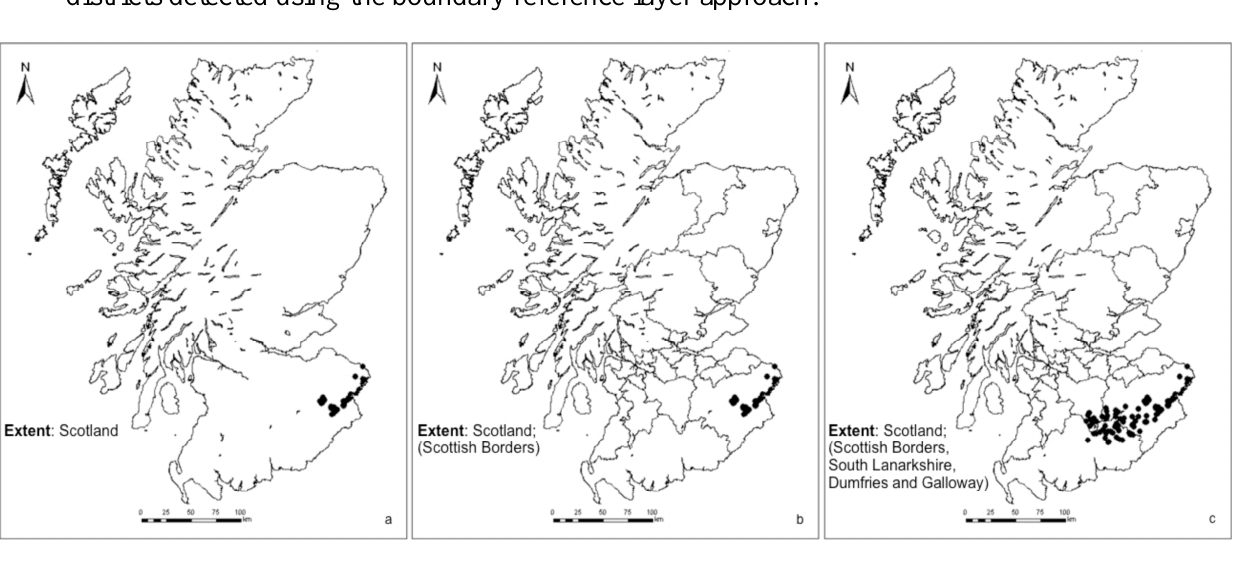
Figure 3. (a-b): Geographic extent estimation of Heracleum mantegazzianum in the south- west of Scotland, 2003-05, and the effects of boundary reference layer granularity (data courtesy of the Tweed Foundation). (c): A hypothetical spread of the species and the districts detected using the boundary reference layer